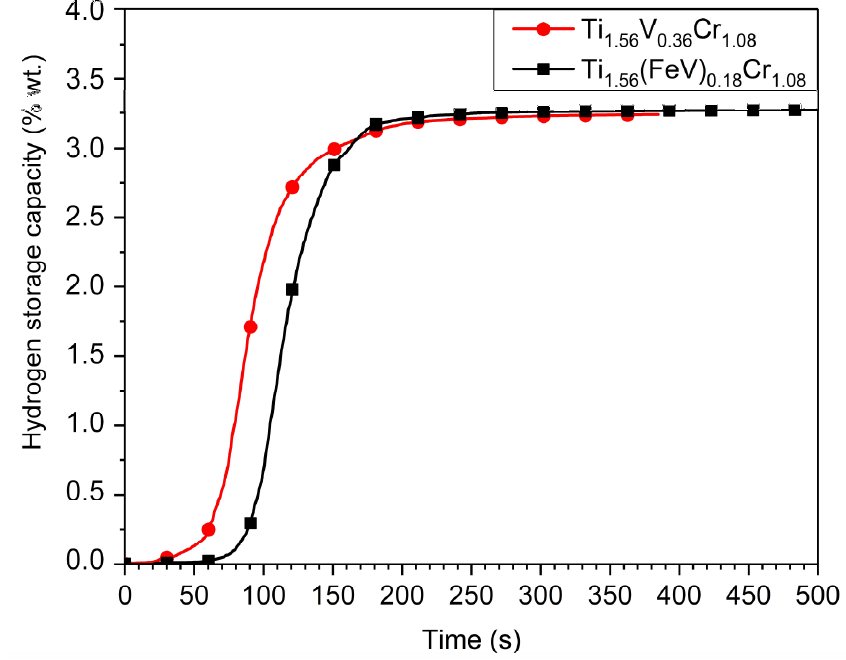
Figure 4. Activation kinetics of the co-melt Ti 1.56 V 0.18 (FeV) 0.18 Cr 1.08 + 4%Zr 7 Ni 10 and Ti 1.56 V 0.36 Cr 1.08 + 4%Zr 7 Ni 10 under 20 bars of H 2 at 25 °C.